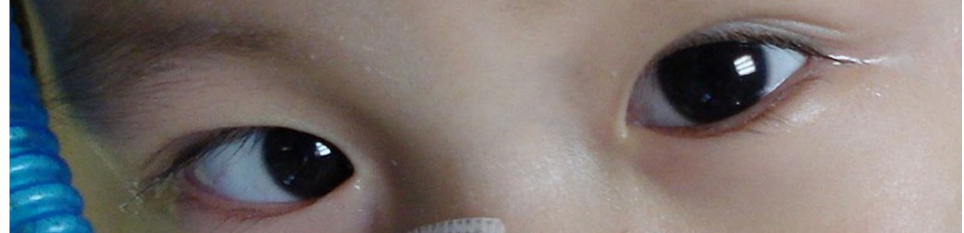
Figure 1. Eye movement was restricted in the left eye only on lateral gaze, and a left abducens nerve palsy was diagnosed.